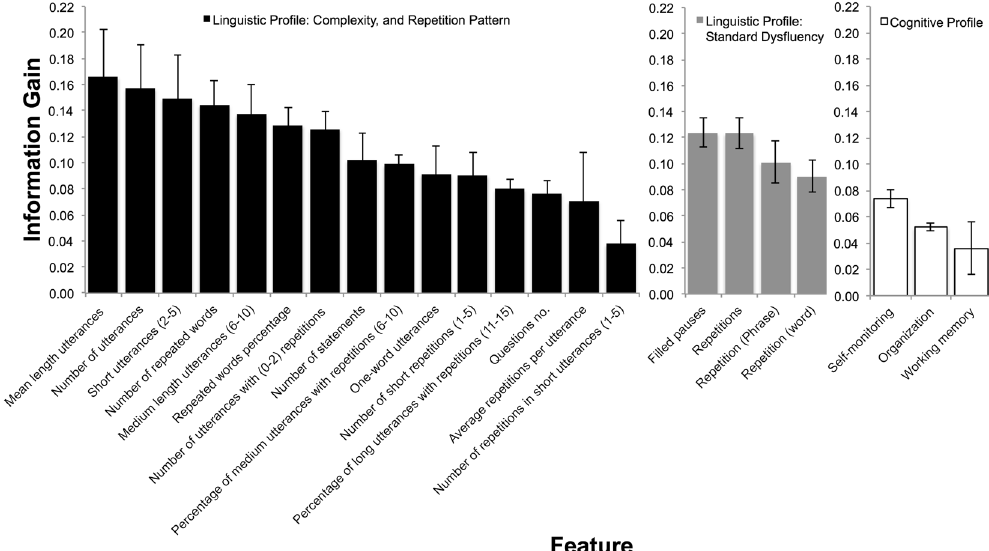
Figure 2. Valuable features with highly ranked information gain. Values are reported as mean ± standard deviation and presented in descending order within each type of feature. Higher value indicates higher information gain. See Table 2 for a description of the